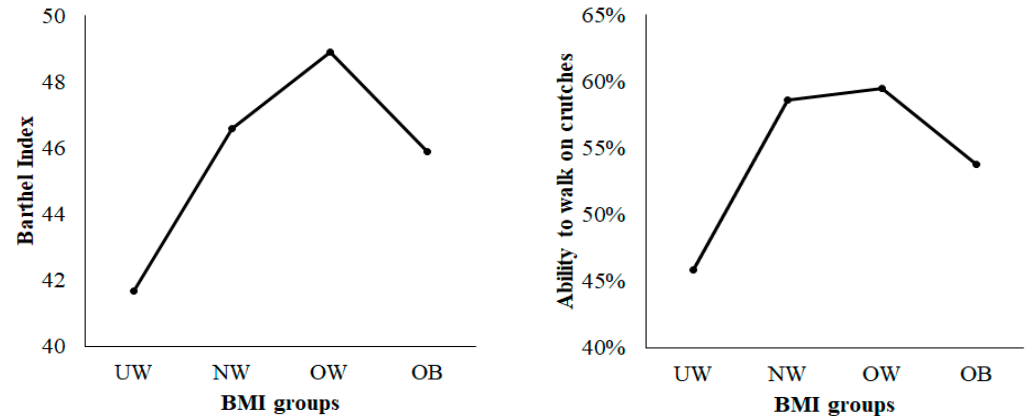
Figure 2. Line graph with reversed J-curve shape, demonstrating the functional status represented by the Barthel index score and mobilization on crutches for the BMI groups (UW = underweight; NW = normal weight; OW = overweight; OB = obese)